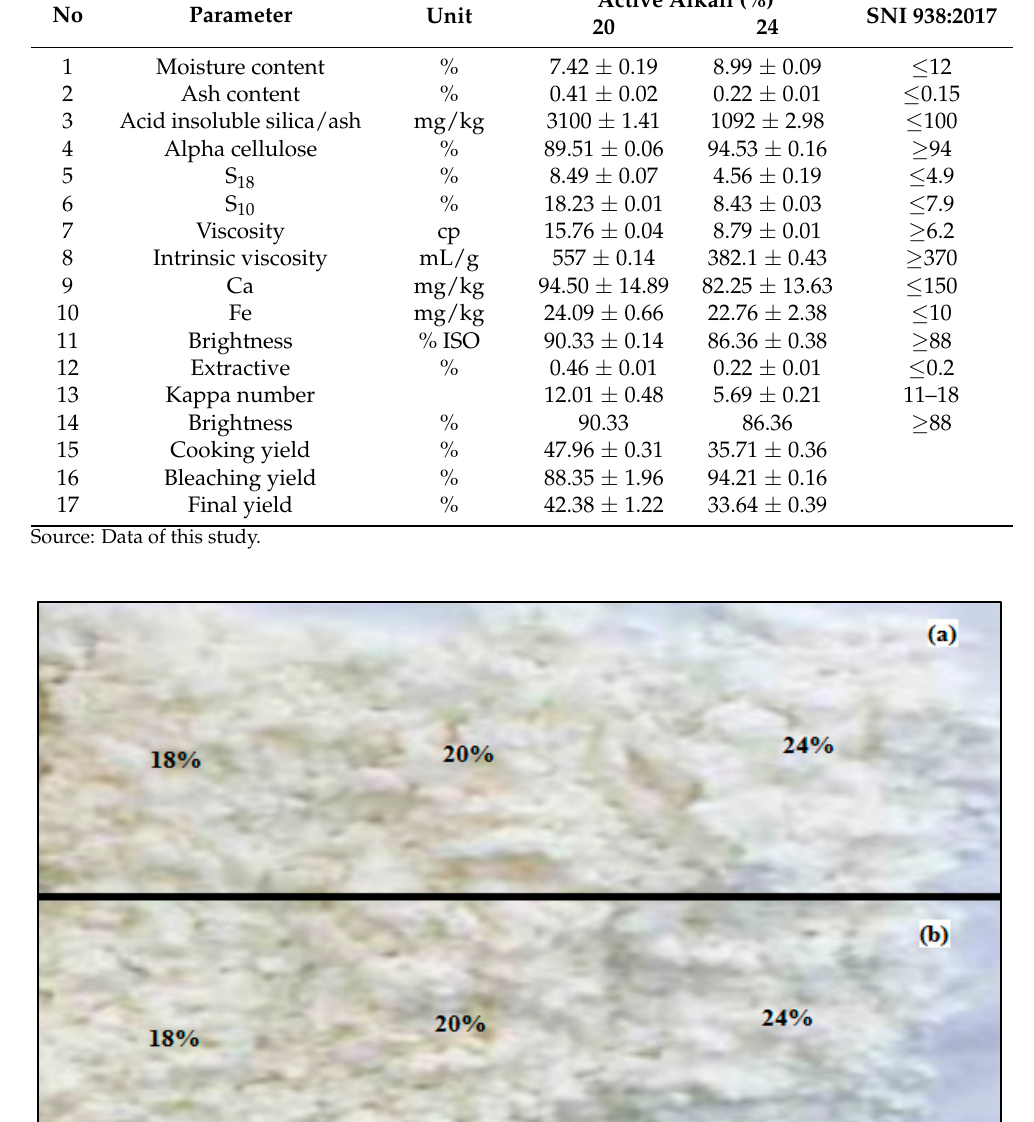
Figure 9. ( a ). Morphological observations using scanning electron microscopy (SEM) on WEFB viscose fibers; ( b ). Morphological observations using SEM on SEFB viscose fibers.